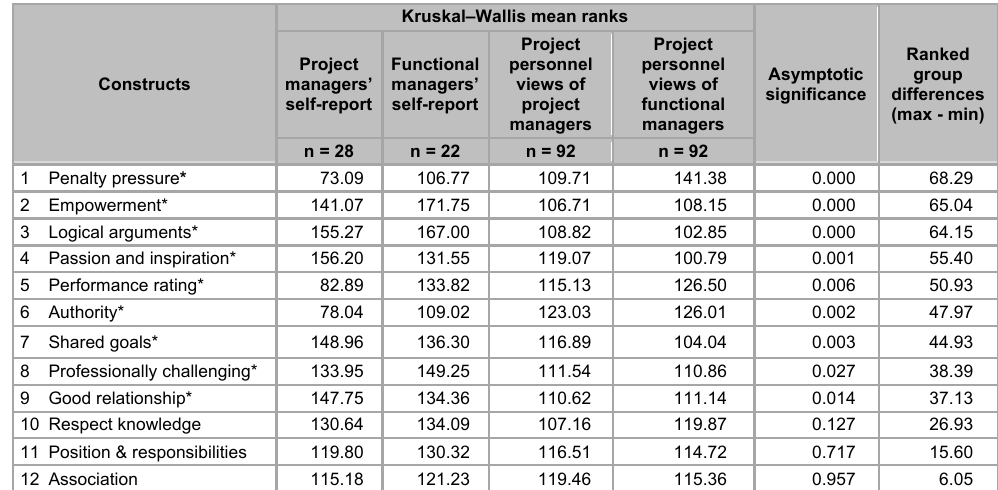
Table 4 Ranked differences in Kruskal–Wallis means across all